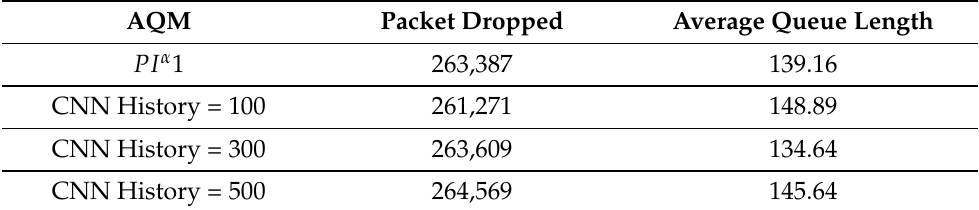
Table 9. Detailed results of queue occupancy obtained for CNN model with the last layer activation function Softmax, trained using data regarding PI α 1 controller and parameters: K P = 0.0001, K I = 0.0004, α = − 0.4 and H = 0.9.